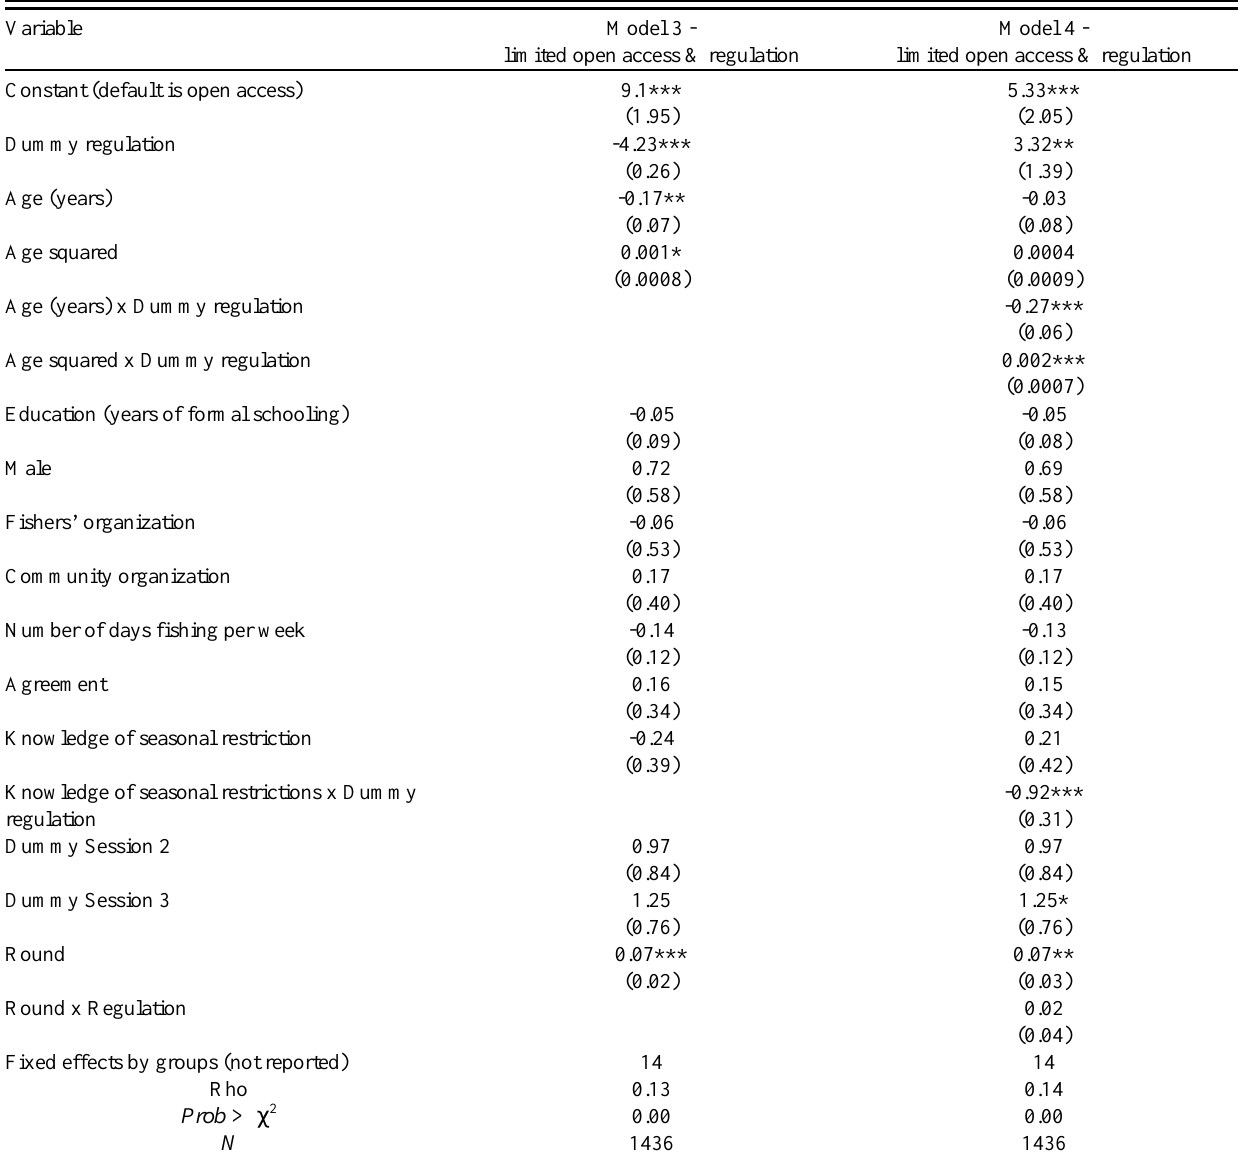
Table 6 . Pooled random effects Tobit estimation of individual extraction (standard error in parentheses)